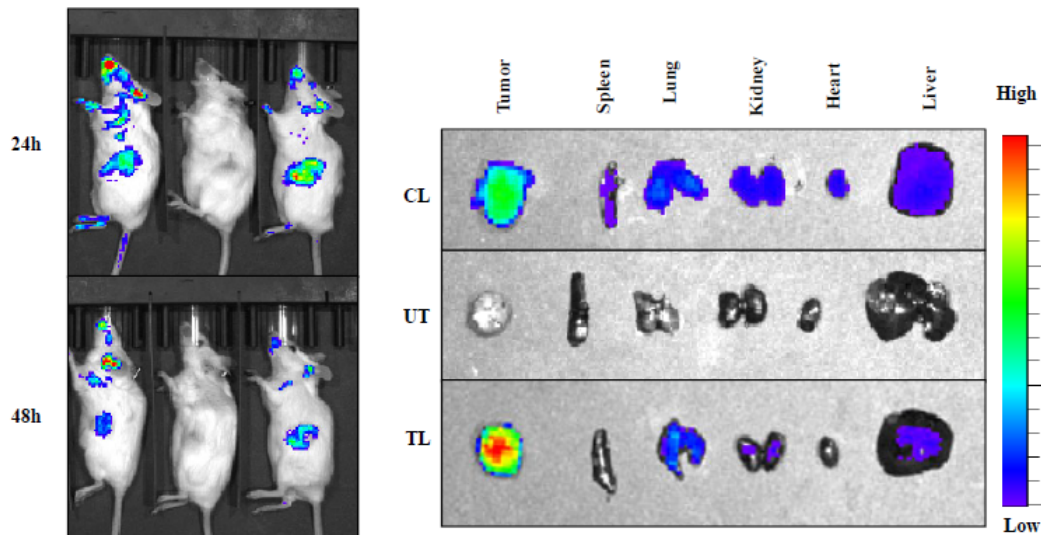
Figure 3. In vivo biodistribution of IR-780-dye-labeled liposomes in orthotopic pancreatic tumor-bearing mice. IVIS (In Vivo Imaging System) imaging showing higher tumor accumulation of IR-780 dye-labeled TTP-conjugated liposomes (TL) compared to control liposomes (CL) at 24 h (upper panel) and 48 h (lower panel) after IV administration into mice bearing AsPC-1 orthotopic tumors in SCID mice. One untreated mouse (UT) was used for background correction. Ex vivo imaging of tumors and major organs harvested at 48 h demonstrated significantly higher tumor uptake of TL compared to CL. Abbreviations: UT, untreated; CL, control liposome; TL, tumor targeting peptide-conjugated liposome.